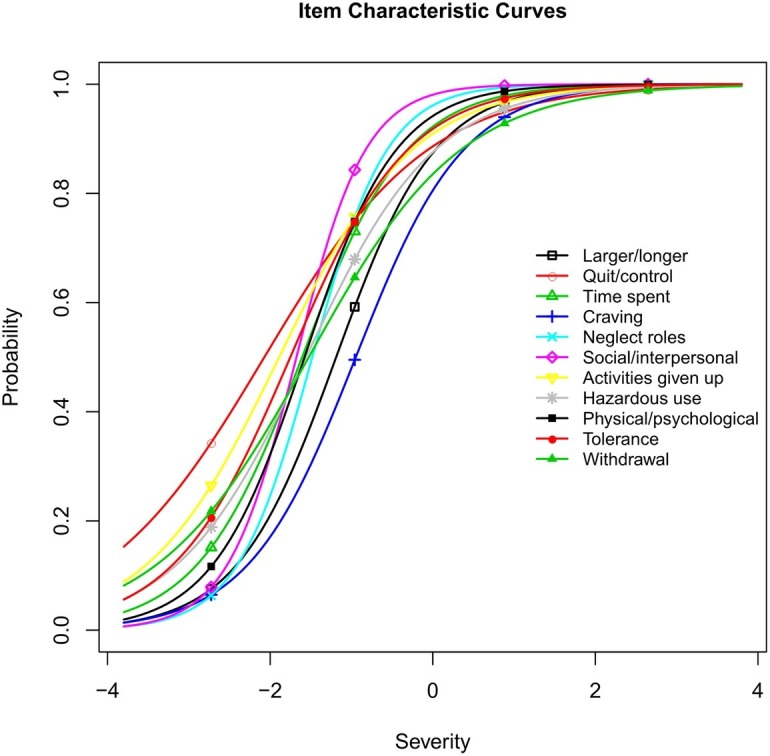
Item characteristic curves for DSM-5 heroin use disorder criteria.